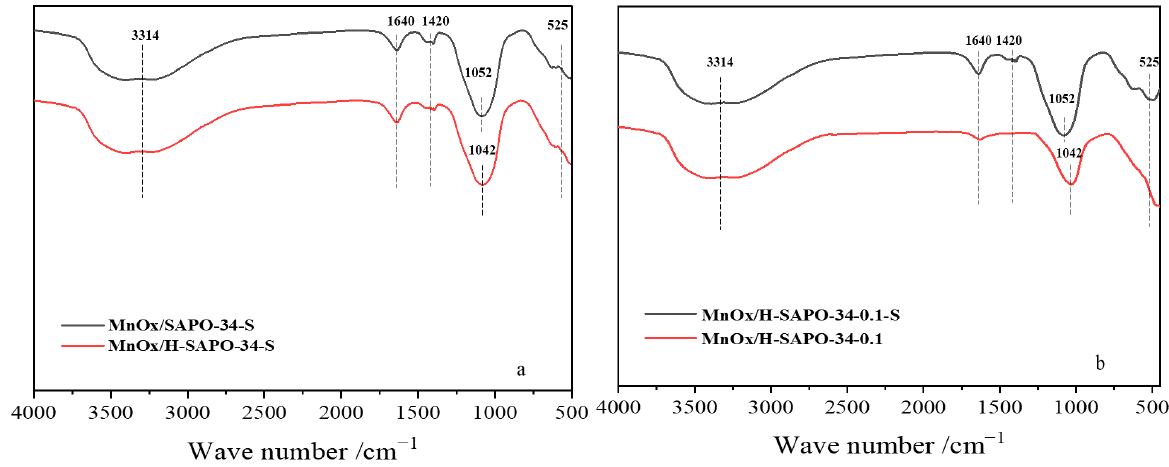
Figure 7. FT-IR spectrum of the fresh and deactivated MnO x /SAPO-34 ( a ) and MnO x /H-SAPO-34-0.1 ( b ) catalysts.